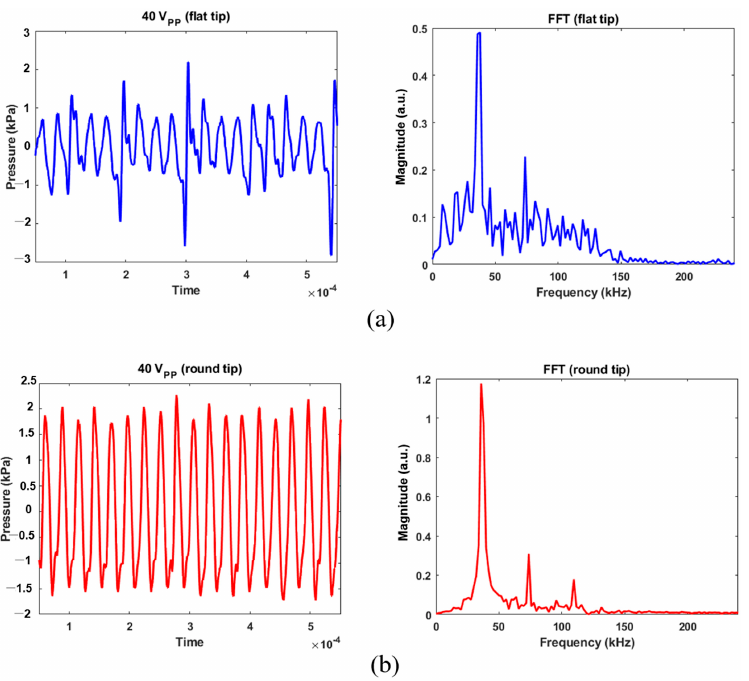
Figure 5. Acoustic pressure calibration for 40 V pp excitation and its FFT results: ( a ) flat tip, ( b ) round tip. Micromachines 2023 , 14 , x FOR PEER REVIEW